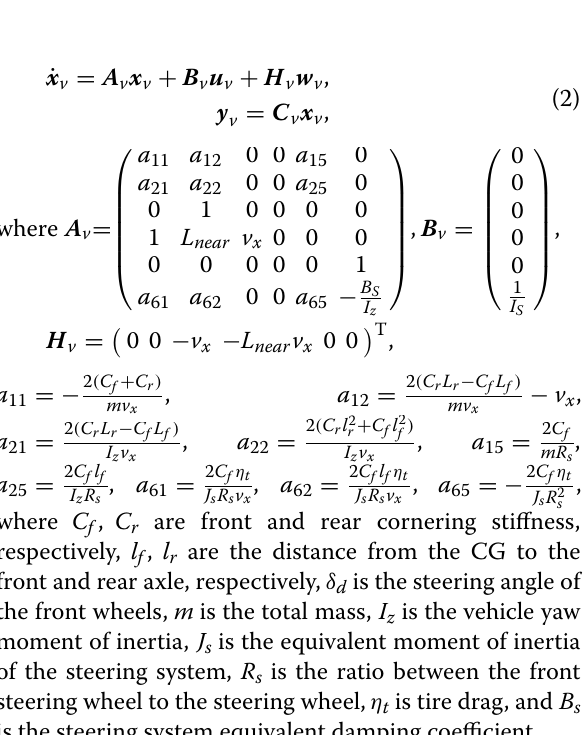
Figure 1 Vehicle-road reference